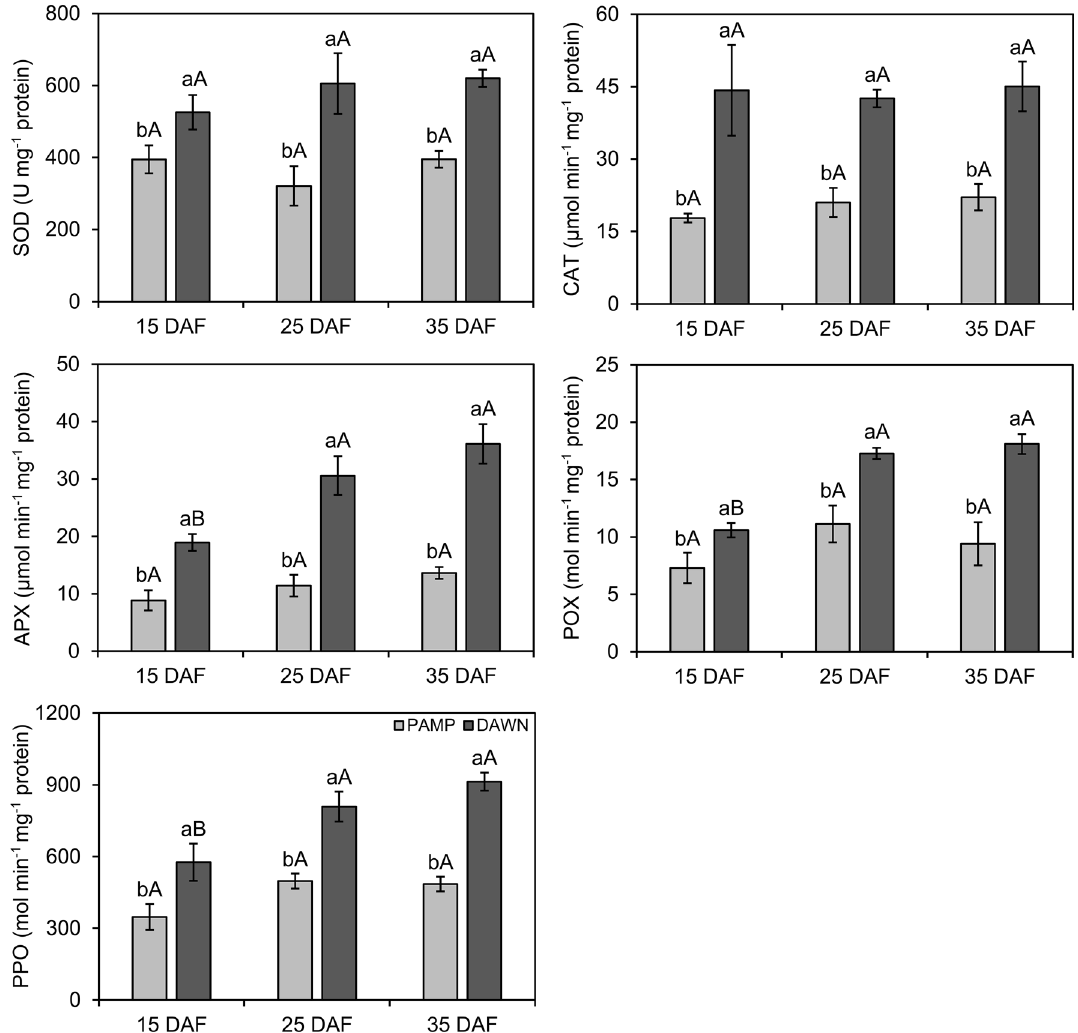
Figure 4. Activities (± SE) of superoxide dismutase (SOD), catalase (CAT), ascorbate peroxidase (APX), peroxidase (POX), and polyphenol oxidase (PPO) in rice roots from susceptible (Ss) and resistant (Rr) cultivars with natural infestations of the South American rice water weevil Oryzophagus oryzae at 15, 25, and 35 days after flooding (DAF). Rice cultivars: PAMP = BRS Pampa CL (Ss) (light gray columns); DAWN = Dawn (Rr) (dark gray columns). Sampling times corresponded to beginning (15 DAF), peak (25 DAF), and decline (35 DAF) phases of larvae infestations in the field. Average numbers of larvae on plants collected for biochemical analysis at 15 DAF: PAMP = 4.94; DAWN = 4.15; 25 DAF: PAMP = 16.56, DAWN = 4.33; 35 DAF: PAMP = 20.81, DAWN = 5.08. Different lowercase letters above bars denote significant differences among rice cultivars at each sampling time, whereas different uppercase letters above bars denote significant differences in the same rice cultivar among sampling times, both by the Scott Knott test ( P ≤ FER concentrations were highest at 35 and 15 DAF, respectively. The concentrations of 4-HX remained unaltered across the sampling times (Fig. 5). Significant differences were observed in the concentrations of 4-HX, FER, and P-CM between cultivars under progressive levels of larval infestation (4-HX: df = 1, F = 12.25, P = 0.003; FER: df = 1, F = 82.69, P ≤ 0.001; P-CM: df = 1, F = 83.31, P ≤ 0.001). The concentrations of phenolic acids were again higher in ‘Dawn’ (Fig. 7). In addition, there were significant differences in the concentrations of FER and P-CM with respect to the “infesta- tion” factor (FER: df = 3, F = 3.56, P = 0.04; P-CM: df = 3, F = 4.52, P = 0.02). FER and P-CM concentrations were significantly higher in infested (2 = 1–3 larvae; 3 = 5–7 larvae; 4 = 9 larvae) than in non-infested ‘Dawn’ plants (1 = 0 larva). The highest concentration of FER in ‘Dawn’ was observed in infestation levels 3 (5–7 larvae) and 4 (9 larvae), which differed from concentrations in infestation levels 1 (0 larva) and 2 (1–3 larvae) (Fig. 7). The concentrations of 4-HX, which were different between cultivars, were not different between non-infested and infested plants (4-HX: df = 3, F = 2.04, P = 0.15) (Fig. 7). In the untargeted metabolomics approach, OPLS-DA was applied to investigate metabolites differentially accumulated in ‘Dawn’ and ‘BRS Pampa CL’. The score plot of the OPLS-DA model exhibited a complete separa- tion among root samples from ‘Dawn’ and ‘BRS Pampa CL’ (Fig. 8a). The robustness of the model was tested using